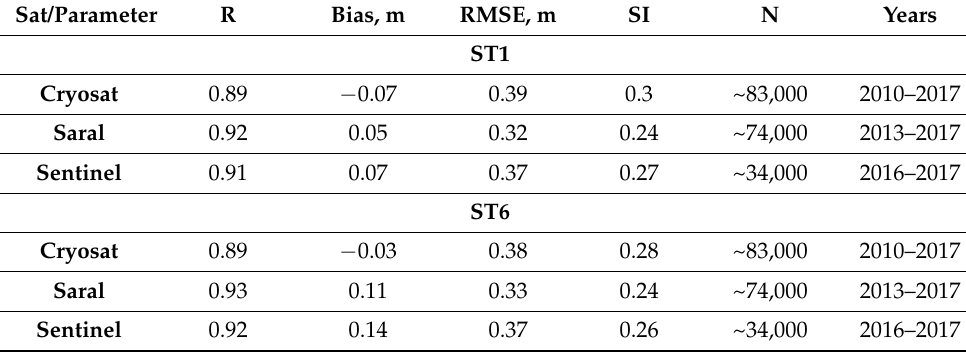
Table 1. Basic statistical parameters of model quality assessments.